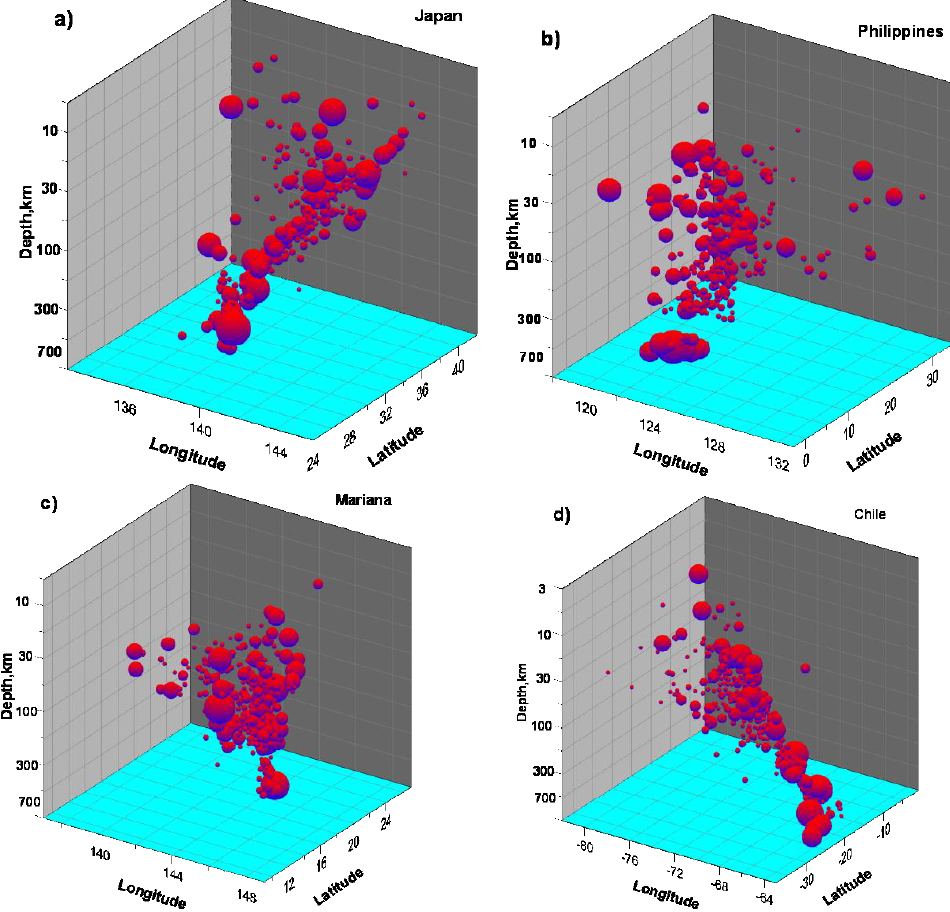
Fig. 2. Distribution of seismic variability indices in several zones during the complete time of analysis: (a) Japan; (b) Philippines; (c) Mariana; and (d)